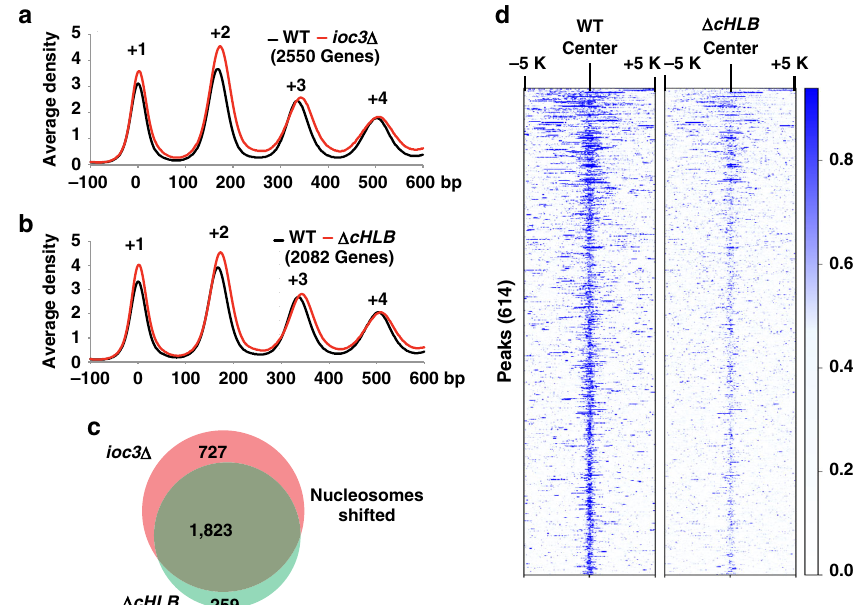
Fig. 9 The HLB domain is required globally for proper nucleosome spacing by ISW1a in mRNA coding regions and stable ISW1a binding. a , b The average nucleosome positioning is shown for those genes in which at least one nucleosome has been signi fi cantly shifted ( p < 0.01) in the + 1 to + 4 nucleosome coding region for either ( a ) ioc3 Δ or ( b ) ioc3 Δ cHLB strains (red) compared to WT (black) as detected by MNase-seq. Data are from three biologically independent samples. c The Venn diagram shows the extent to which genes with signi fi cantly shifted nucleosomes overlap between ioc3 Δ (red) and ioc3 Δ cHLB (green). d The heatmap is based on 614 high con fi dence Ioc3 peaks (blue) in wild type and compared wild-type and ioc3 Δ cHLB mutant signals at these sites. The data are from biologically independent replicates. The high con fi dence ChIP-seq peaks of Ioc3 were determined by analyzing with MACS2 ( q <